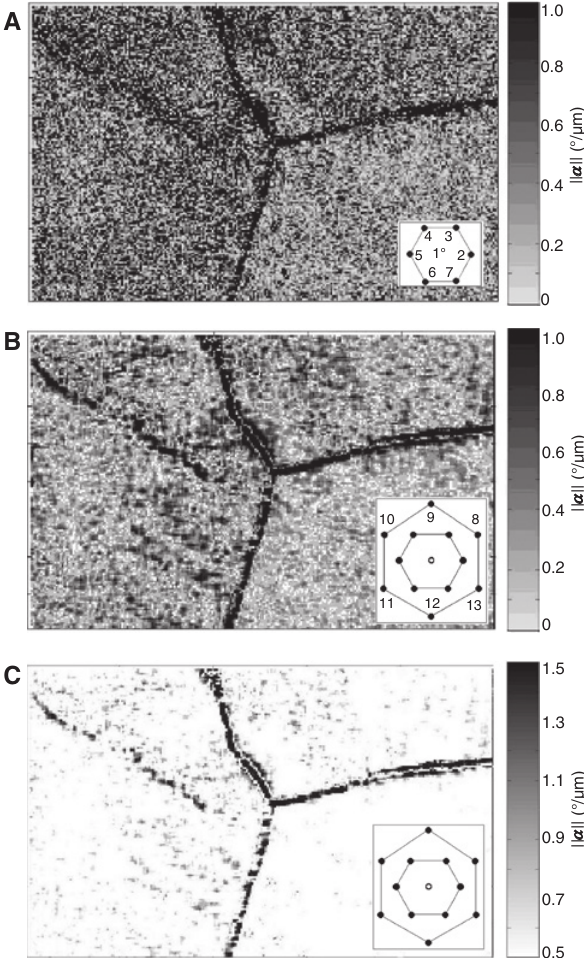
Figure 3: Measure of lattice curvature (magnitude of rotation divergence in the range of 1 ° / μ m width) mapped at zero threshold with small (A) and large (B) differentiation domains, and (C) at an elevated threshold with the large domain. Spacing of data points in insertions is exaggerated.